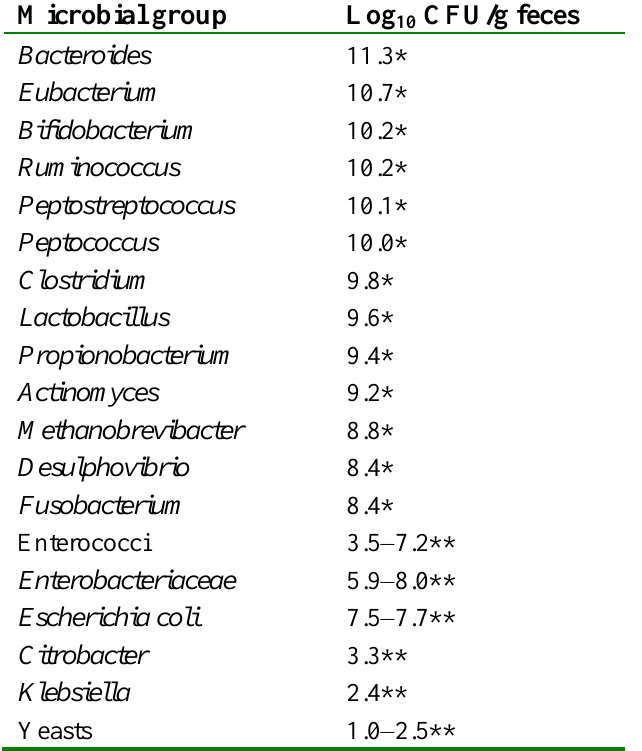
Table 6. Total viable count in feces of healthy humans (children, adults and elderly) a